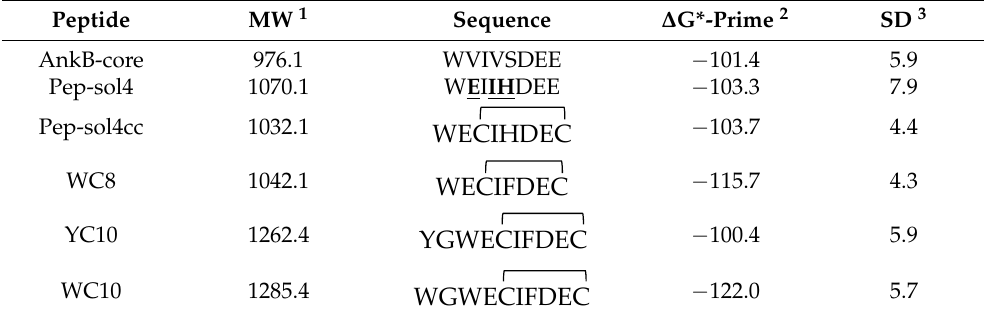
Table 2. Sequence and calculated Δ G* values of AnkB-core analogs. Peptide MW 1 Sequence